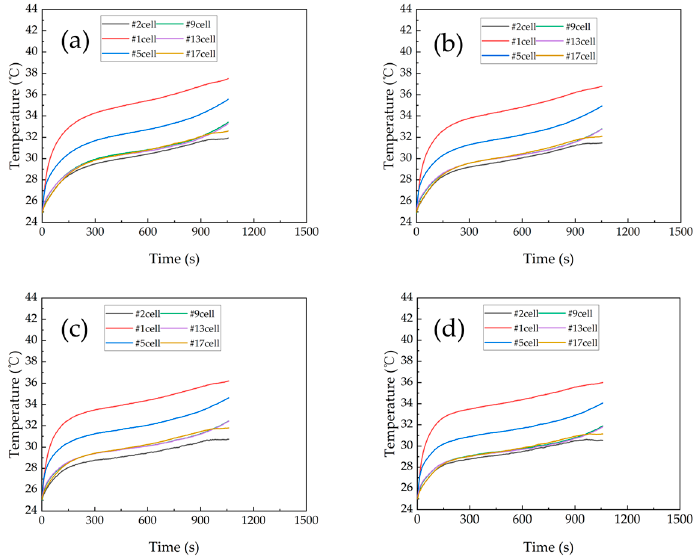
Figure 6. The change of ba tt ery module temperature with discharge time at di ff erent fl ow speeds [31]: ( a ) 0.2 m/s, ( b ) 0.3 m/s, ( c ) 0.5m/s, ( d ) 0.7 m/s.